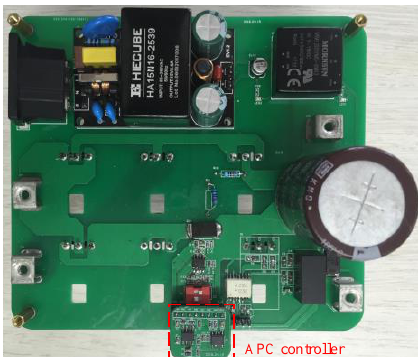
Figure 13. Photograph of APC receiver.